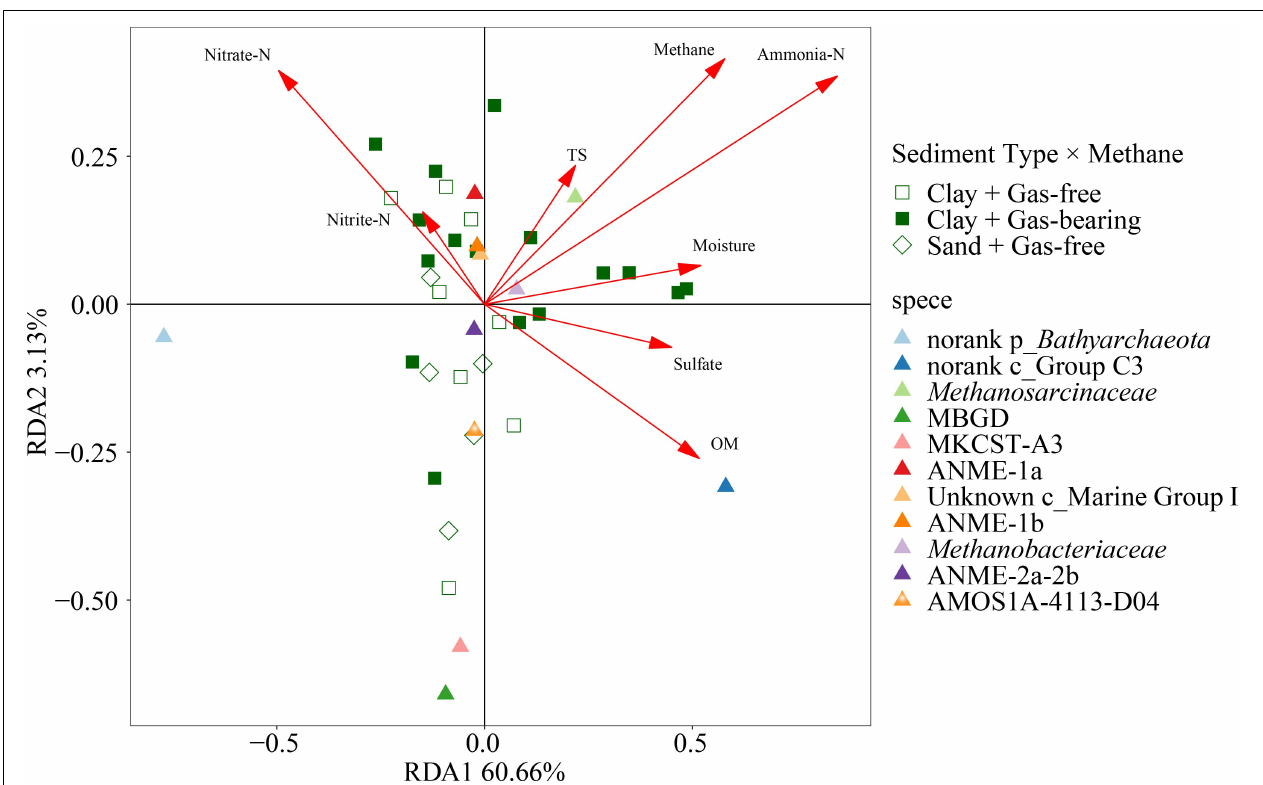
FIGURE 7 | Ordination plot of redundancy analysis (RDA) for the dominant archaeal families with methane and environmental substrates as constraining